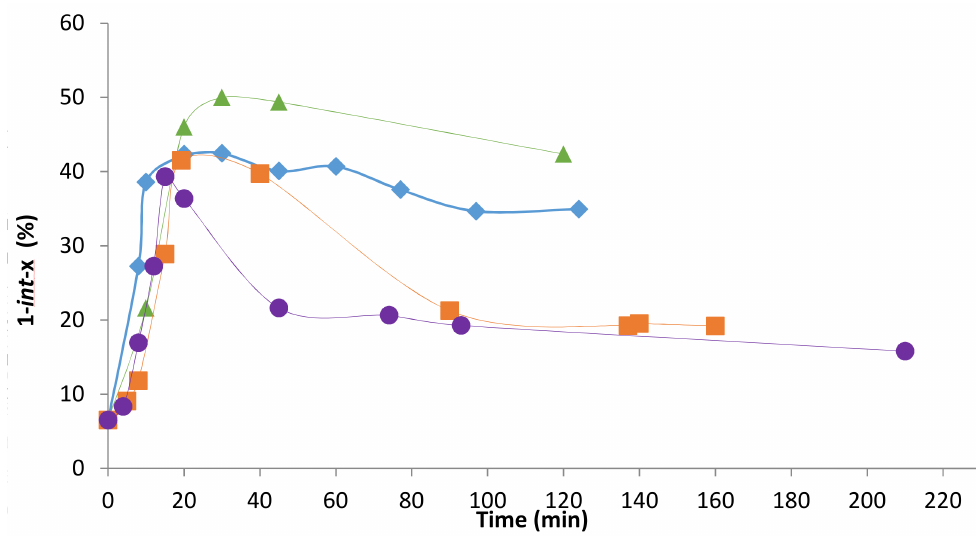
Figure 6. Influence of syngas pressure (CO/H 2 = 1:1) on the amount of internal isomers ( 1- int -x ) as a function of time in tandem isomerization-hydroformylation of 10-undecenitrile at [ 1 ] 0 /[Rh] = 3000 ( (cid:78) 4 bar, (cid:7) 8 bar, (cid:4) 20 bar, 40